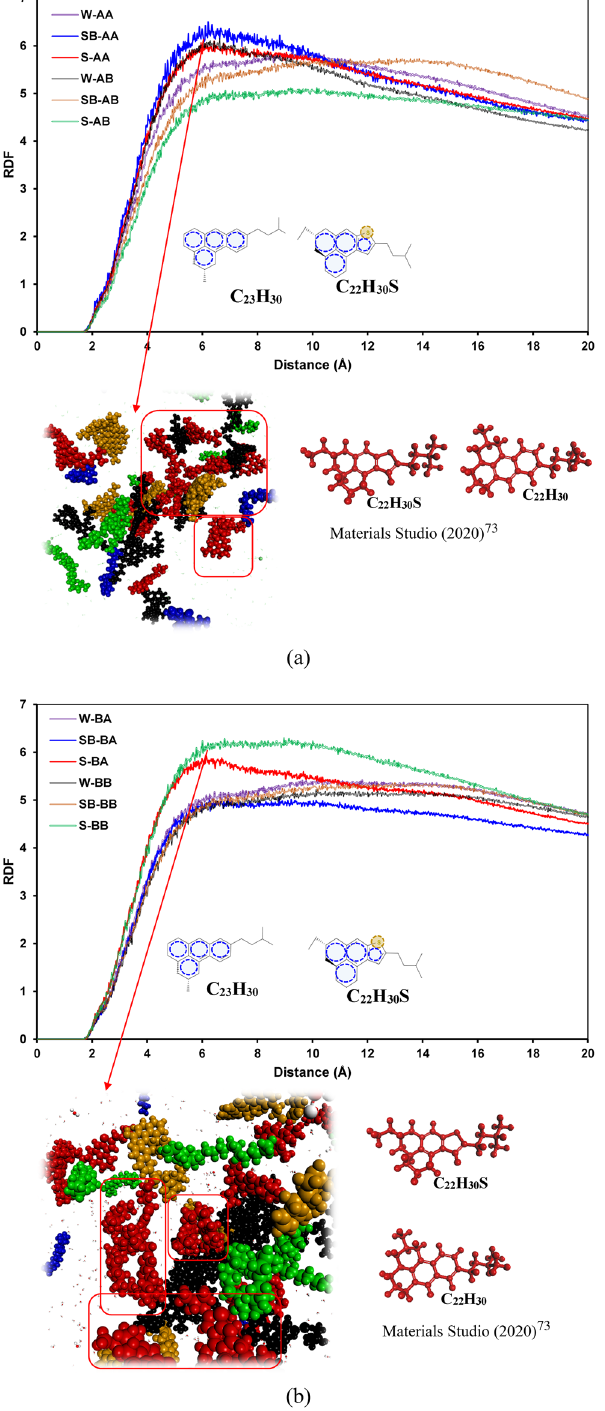
Figure 8. RDFs of the resin–resin molecule pairs containing ( a ) C 40 H 30 O 2 and ( b ) C 44 H 40 N 2